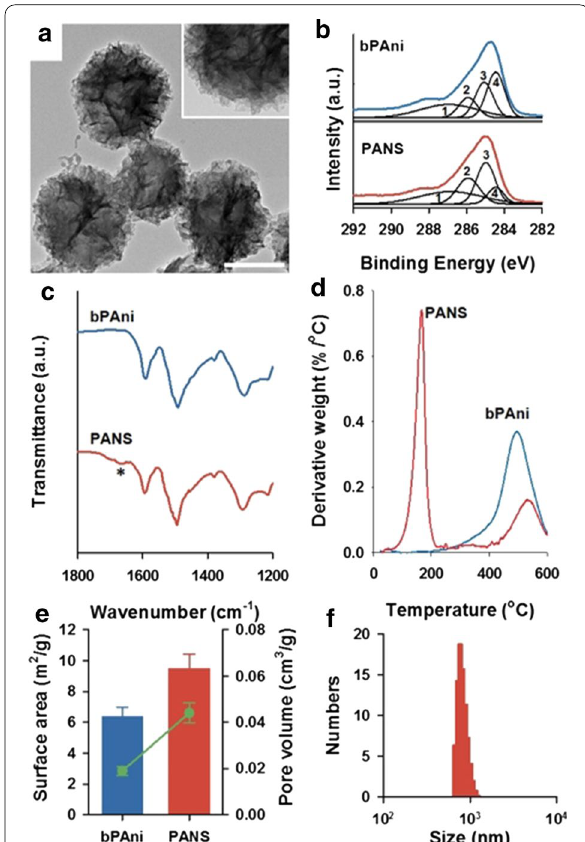
Fig. 3 a High-resolution transmission electron microscopic (HRTEM) images of PANS. Scale bar is 100 nm, and inset is a high magnification image. b XPS C1s spectra of bare polyaniline (bPAni) (upper) and PANS (lower). 1: C O/C–O, 2: C–N + /C N + , 3: C–N/C N, 4: C–C/C–H. = = = c FTIR spectra of bPAni (upper) and PANS (lower). An asterisk represents a interesting peak described in more detail in the text. d Thermogravimetric analysis (TGA) of bPAni (upper) and PANS (lower). e Surface area (bar) and pore volume (line and scatter) of bPAni and PANS using Brunauer–Emmett–Teller (BET) analysis. f Size distribution of PANS via dynamic light scattering (DLS)